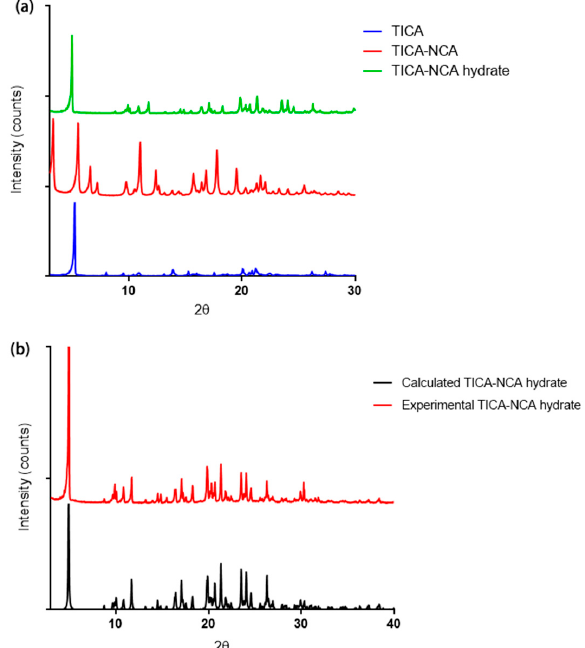
Figure 2. ( a ) The PXRD patterns of TICA, TICA-NCA, and TICA-NCA hydrate and ( b ) experimental and simulated XRD patterns of TICA-NCA